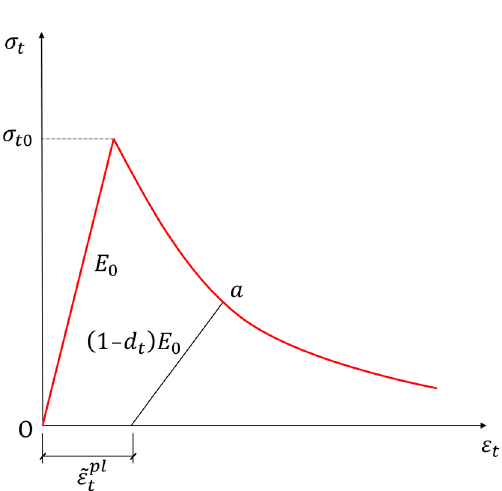
Figure 5. Stress-strain relationship for concrete under uniaxial tension.